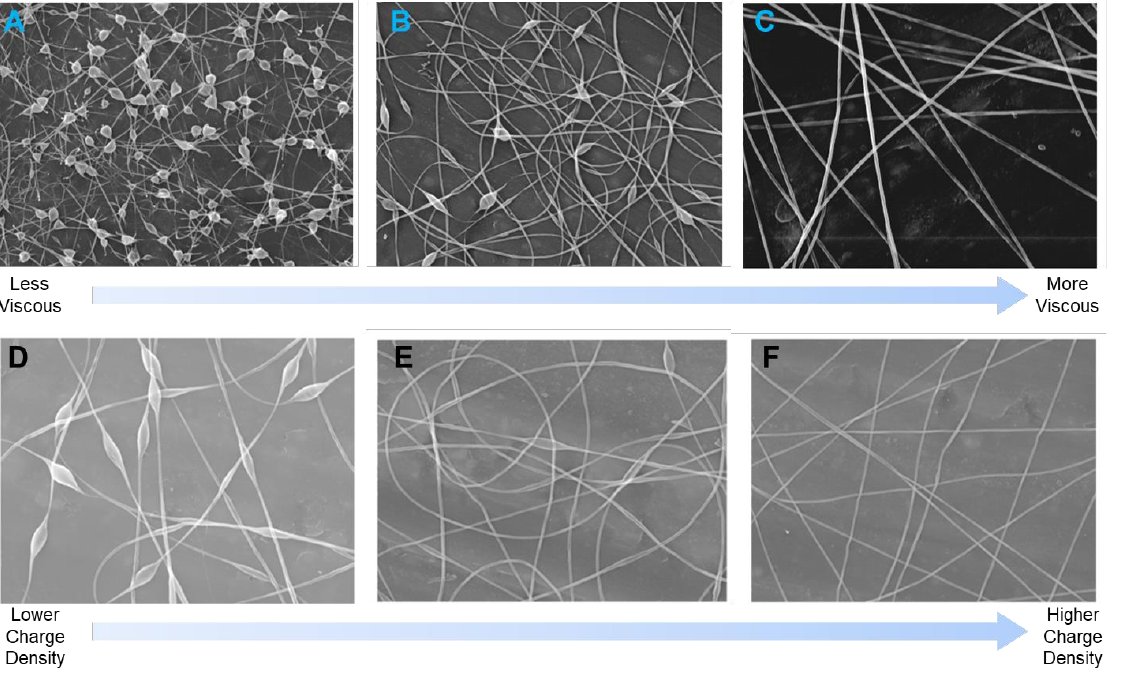
Figure 7. Increasing viscosity or conductivity (charge density) reduces bead formation [135]. Top: Scanning electron micrographs (SEMs) of electrospun aqueous poly(ethylene oxide (PEO). The horizontal edge of each image is 20 µm long: ( A ) 1.5 wt.% PEO, 32 cP; ( B ) 3 wt.% PEO, 289 cP; ( C ) 4 wt.% PEO, 1250 cP. Bottom: Electrospun 3 wt.% PEO with increasing NaCl content: ( D ) 15 ppm NaCl, 1.23 C·L −1 ; ( E ) 300 ppm NaCl, 3.03 C·L −1 ; ( F ) 1500 ppm NaCl, 28.8 C·L −1 . Reprinted from Ref.